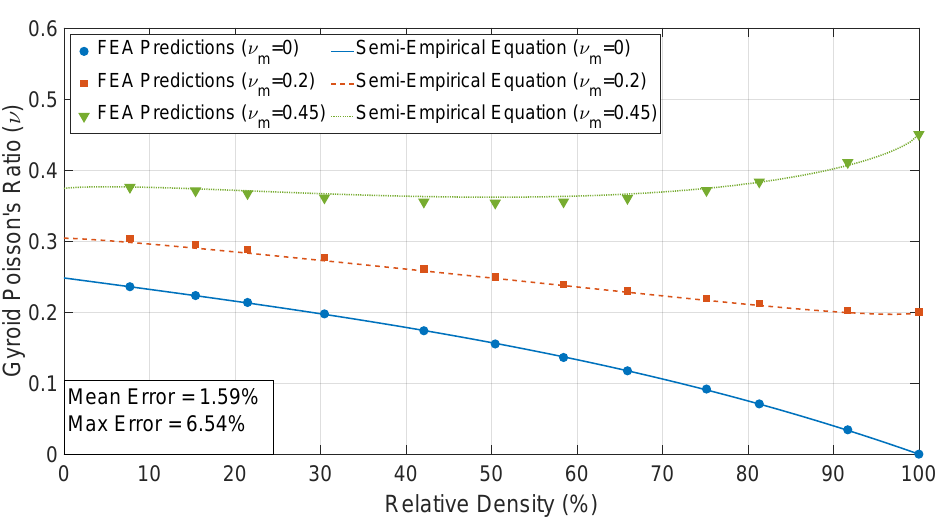
Figure 15. FEA predictions vs. semi-empirical equation for Poisson’s ratio.